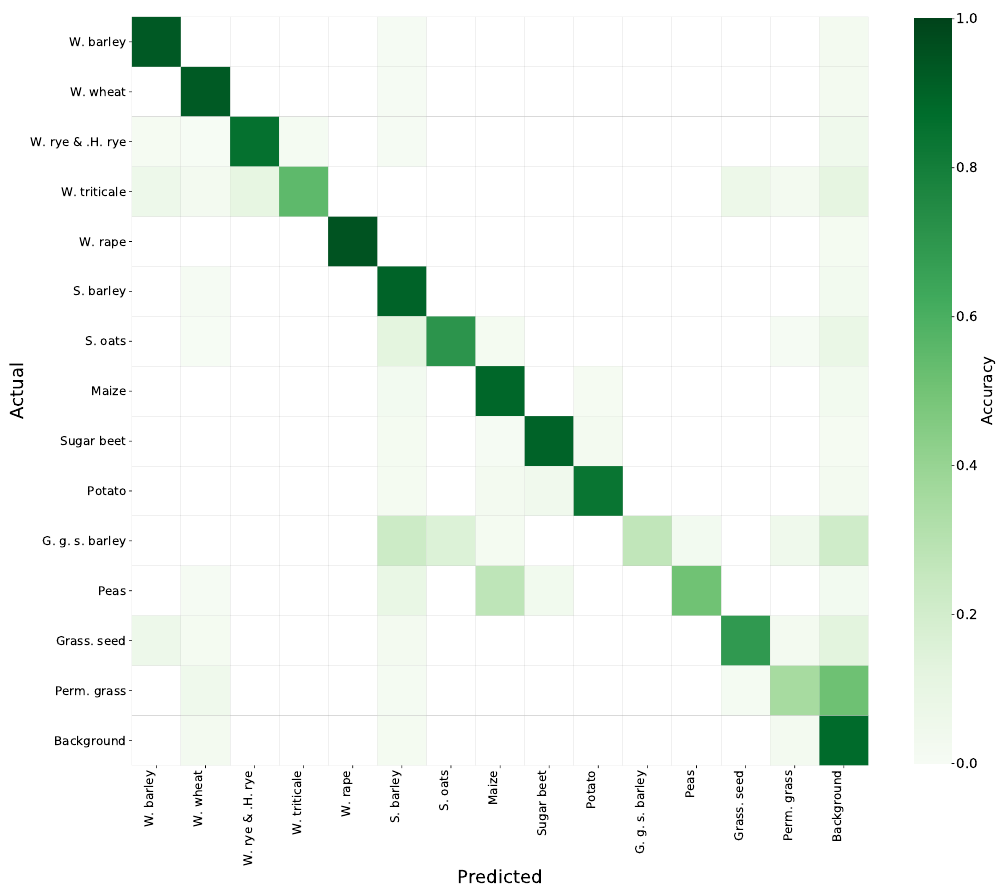
Figure 6. Normalized confusion matrix obtained from the proposed network with 15 di ff erent classes. The highest accuracies were achieved for winter rapeseed, winter barley, winter wheat, spring barley, and sugar beet, achieving 95%, 94%, 93%, 90%, and 90% accuracies, respectively. The network, however, had trouble classifying green grain spring barley and permanent grass correctly. Green grain spring barley was mostly confused with spring barley, which makes sense since the only di ff erence between the two is the time of harvest. The only di ff erence is, therefore, the last images from the season. Permanent grass is mostly confused with the background class, which is believed to be caused by